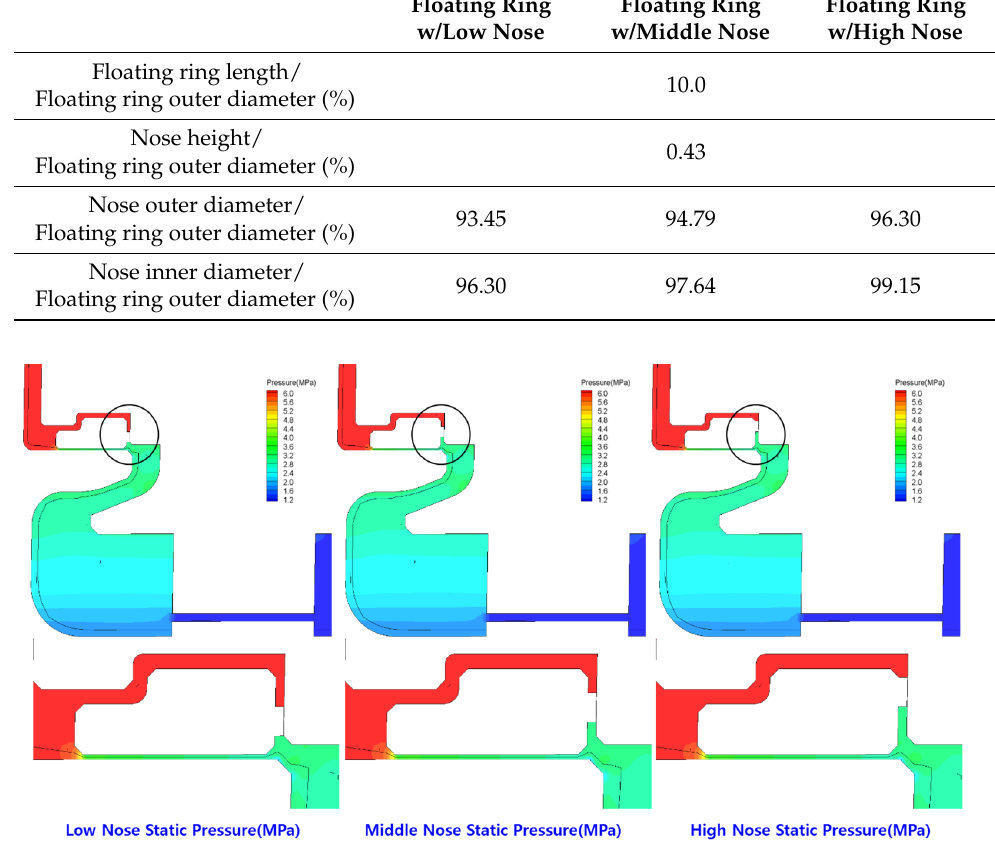
Figure 12. Static pressure (MPa) distributions with change in nose height.